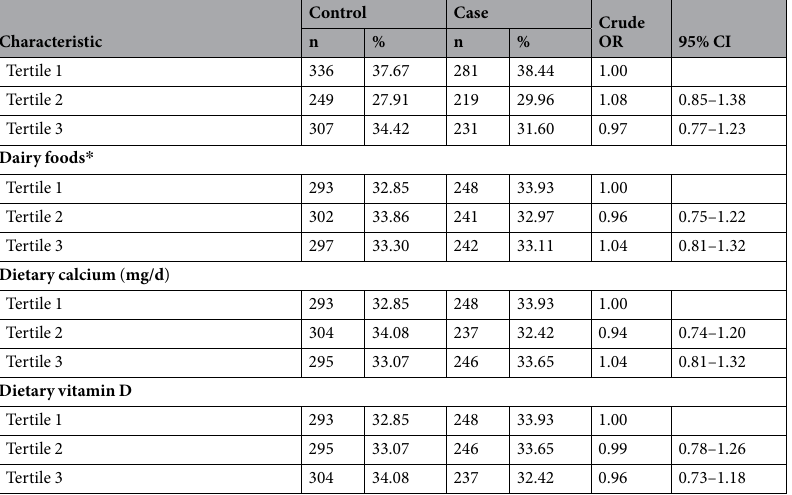
Table 1. Characteristics of the MCC-Spain study participants. * Dairy foods include milk, yogurt and cheese. Associations with P < 0.05 are shown in